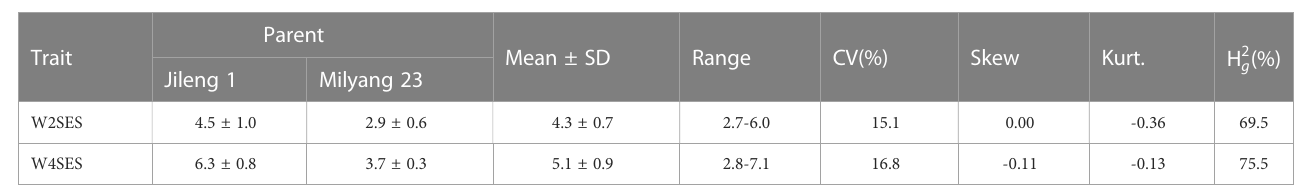
TABLE 2 SES of salt tolerance in parents and